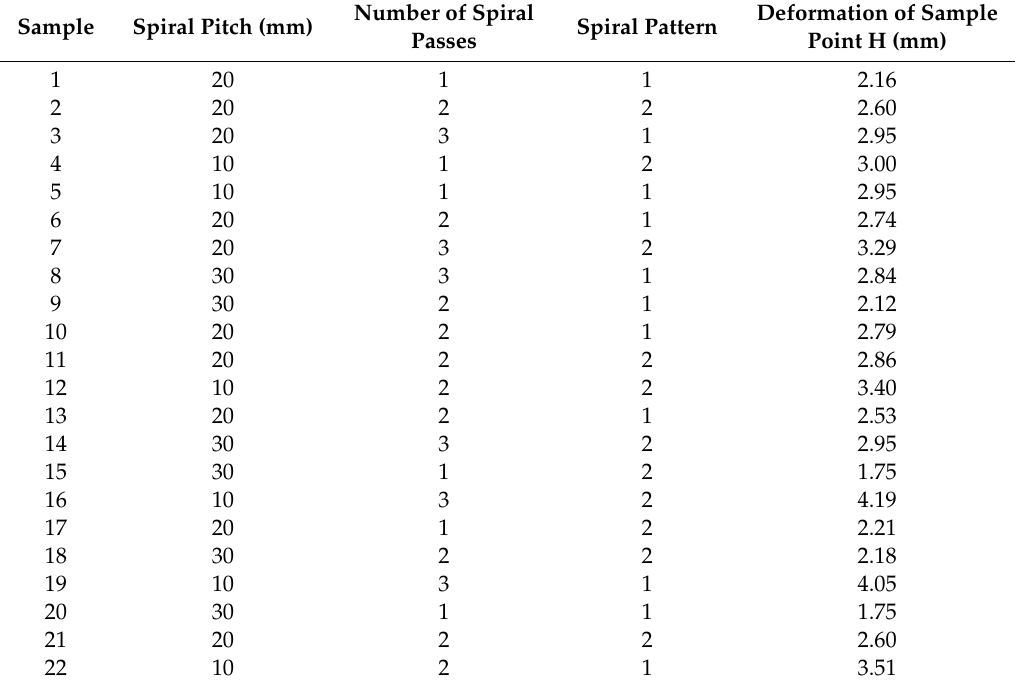
Table 3. The experimental test plan designed according to Response Surface Method (including the results).